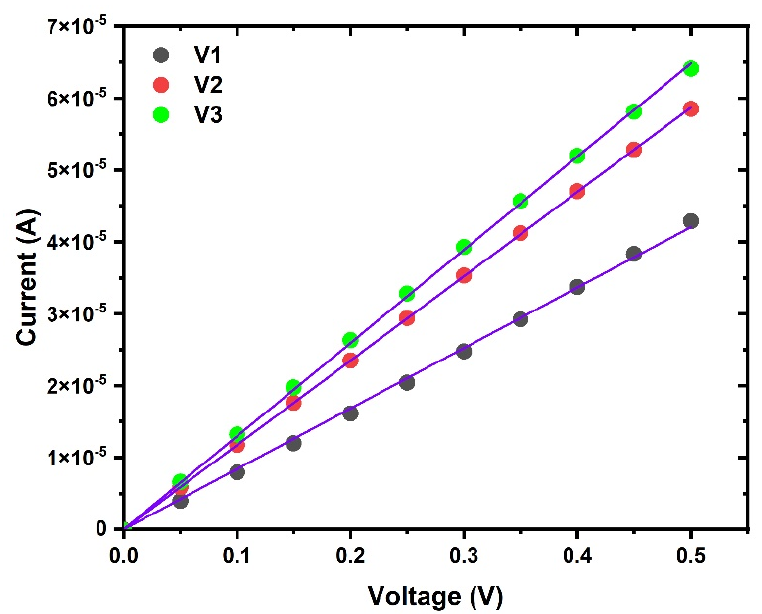
Figure 9. Experimental I–V characteristics (symbols) associated with the mean LRS currents ex- tracted from DC set operations of V1, V2 and V3 memristive devices. The solid lines are simulated characteristics using the QPC model for LRS (Equation (3)).